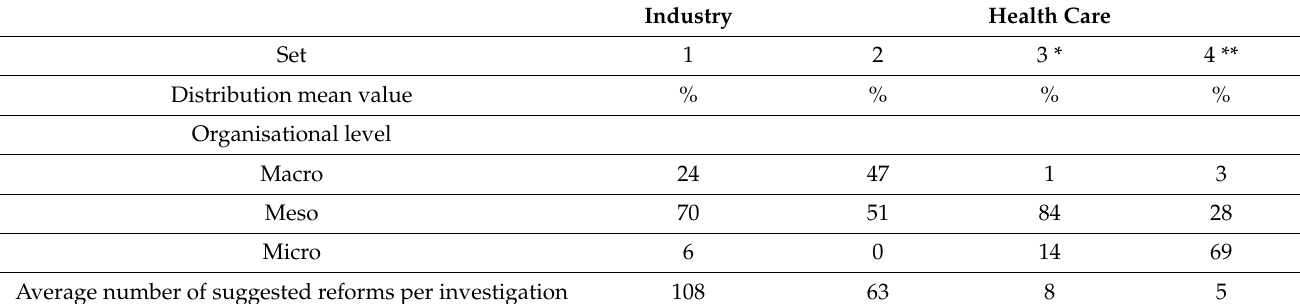
Table 10. Mean values of organisational levels of reforms in different studies.